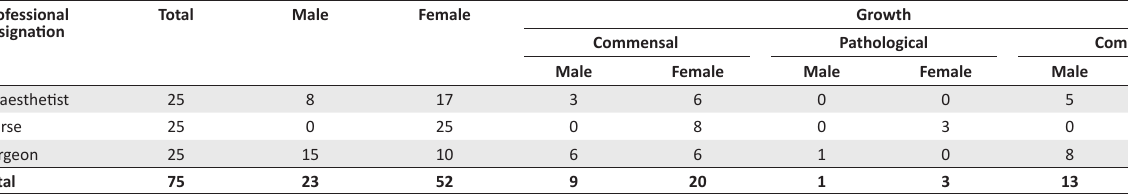
TABLE 1: Growth according to